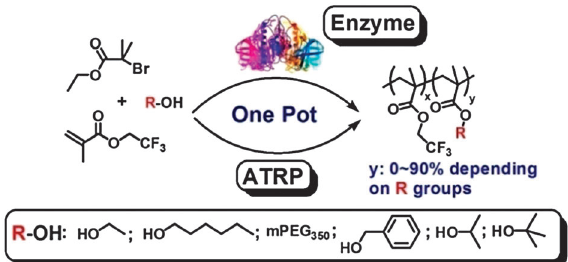
Figure 14. Concurrent ATRP and side group modification by enzyme catalyzed transesterification. Adapted with permission from [73], Copyright© 2012 Royal Society of